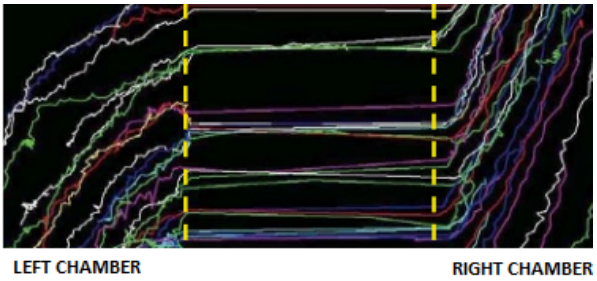
Figure 2. Diagonal trajectories driven by the chemical signal of immune cells from the right chamber to the left chamber, crossing the microchannels. Credit: Crop of picture in Agliari et al. (2014), Reference [6]. In order to show immune cells’ migration, an image of the diagonal paths from the left to the right chamber covered by leukocytes following the chemical signal secreted by tumor cells is depicted in Figure 2. It is worth noting that in Figure 2, a subarea of the domain reported in Figure 3 is shown. For this reason, some cell trajectories appear in the diagonal-lower part of the picture.